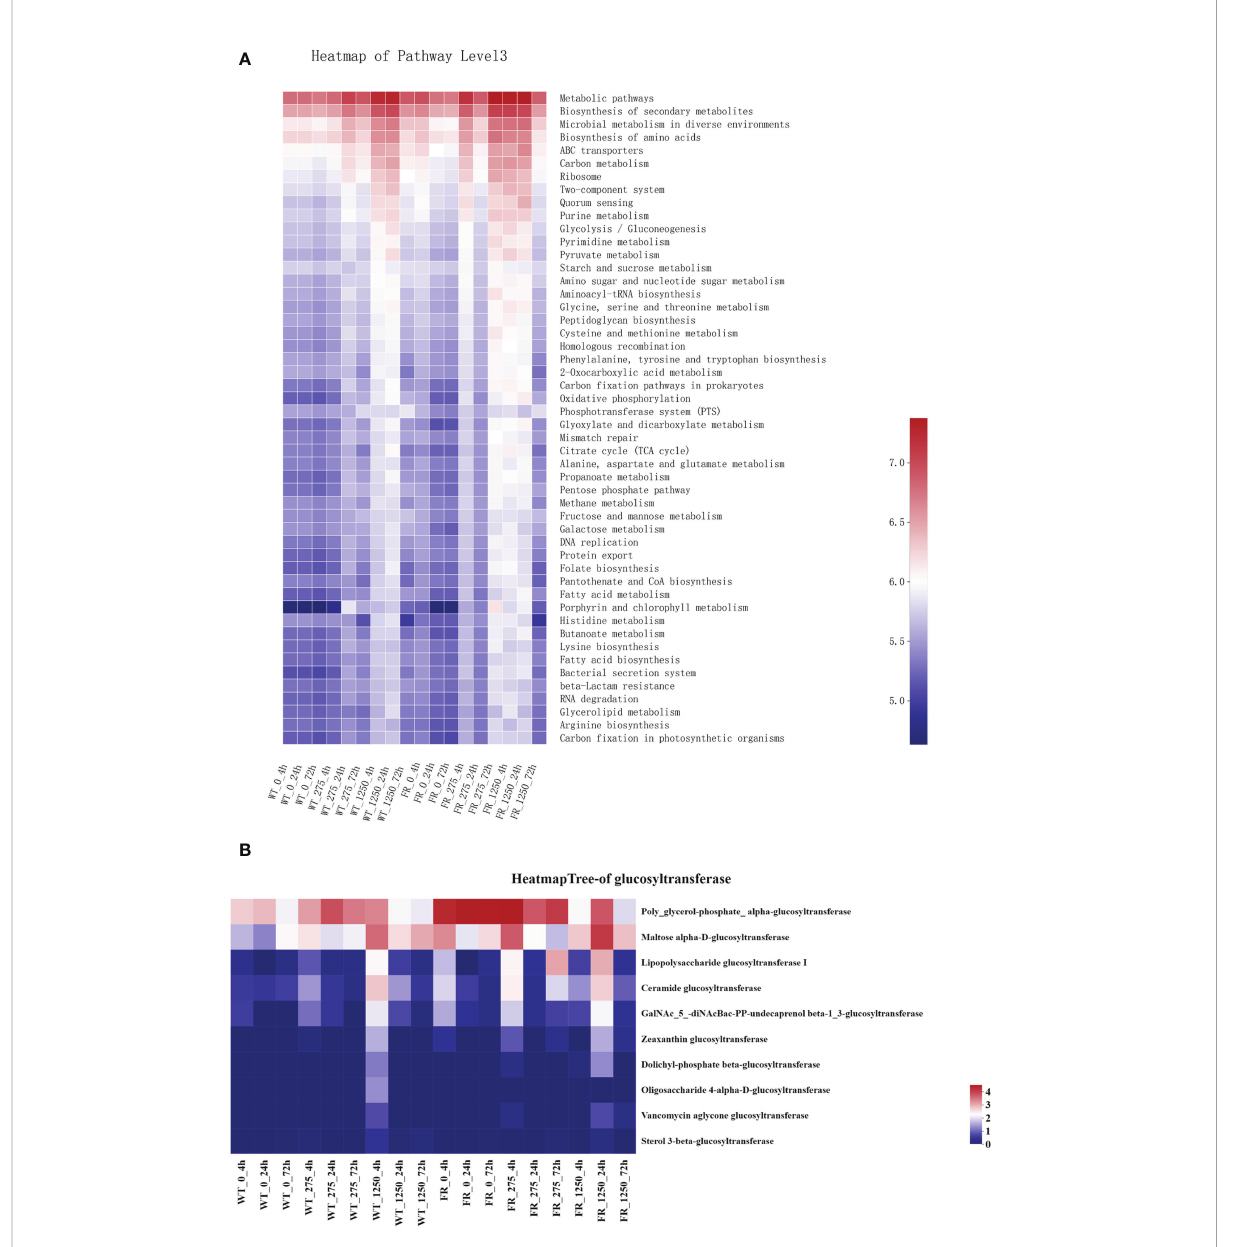
FIGURE 7 Prediction of Kyoto Encyclopedia of Genes and Genomes pathways and major glucosyltransferase of bio fi lms. (A) Prediction of KEGG pathways. The color gradient of the color block is used to display the changes in the abundance of different functions in the groups, and the legend indicates the value represented by the color gradient. (B) Major glucosyltransferase of bio fi lm in the presence of WT/FR. The color gradient of the color block is used to display the changes in the abundance of different functions in the groups, and the legend indicates the value represented by the color